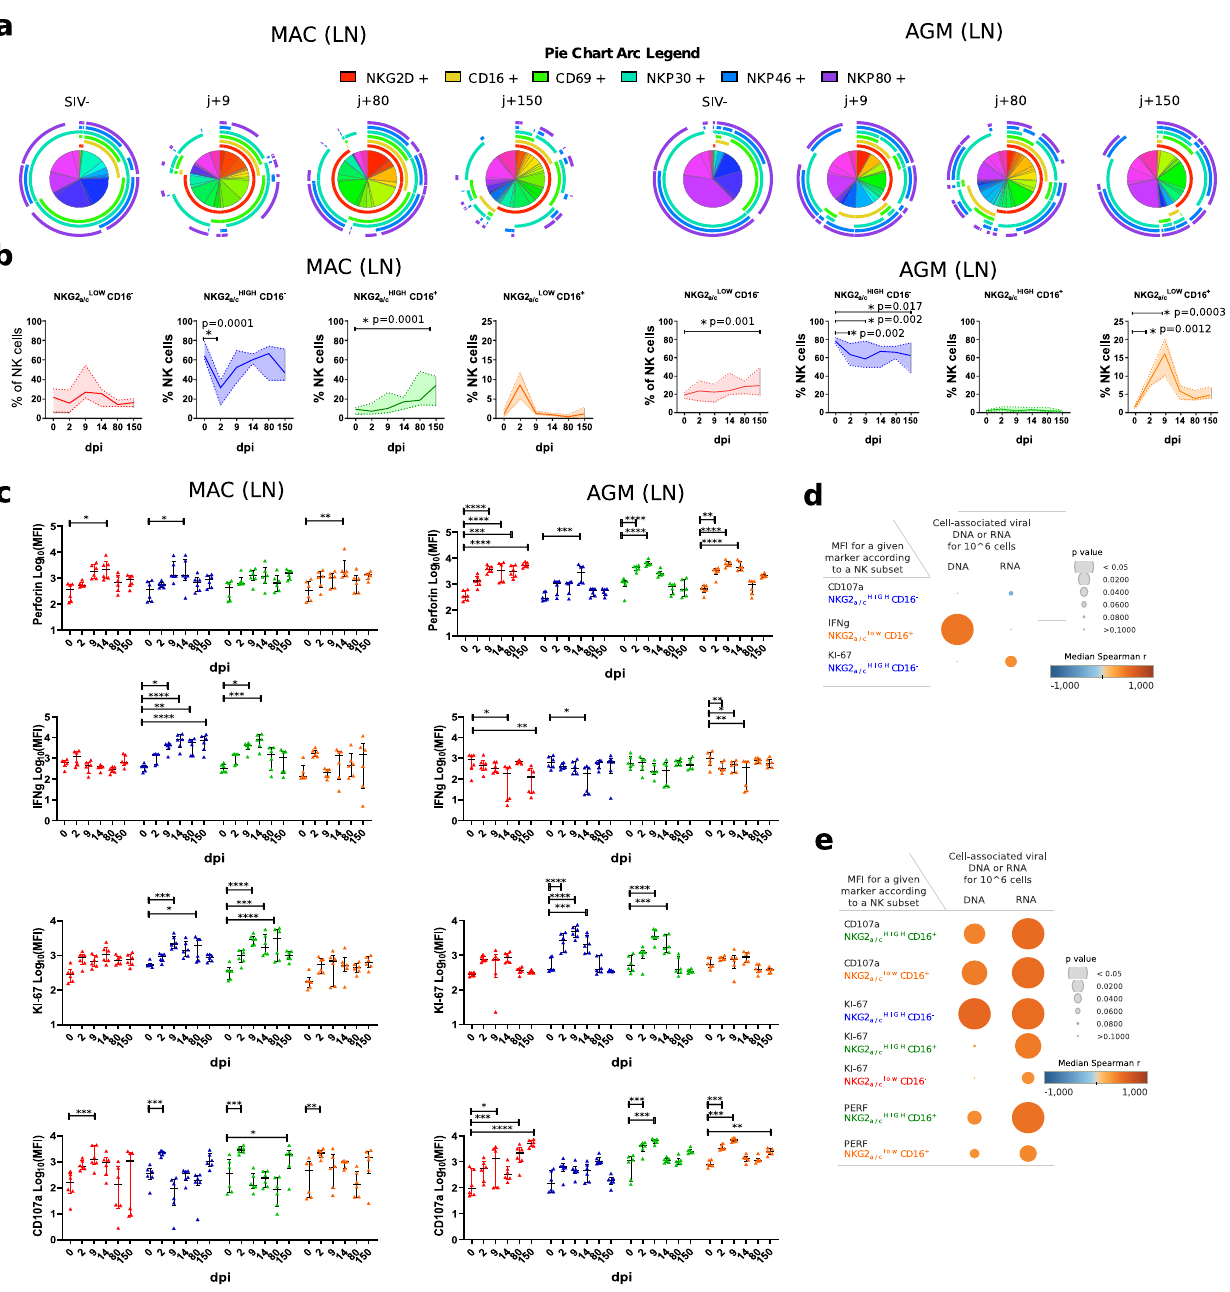
Fig. 3 Dynamics of NK cell repertoire and activity in response to SIV infection in LN. a Pie charts and arcs showing the proportion of different combinations of markers on NKG2a + NK cells isolated from LN during SIVmac (left panel) and SIVagm (right panel) infections, as analyzed using SPICE 5.3. b Frequency of NK cell subpopulations out of total NK cells in LN. Colors are the same as in Fig. 1. Cells were sampled before and during SIVmac and SIVagm infection ( n = 6 animals per species) at the time point indicated by the X axis. The full line indicates the median, and the interquartile range is indicated by the area between the dotted lines. For Groups comparisons two-sided Wilcoxon signed-rank test with Bonferroni correction were used ( n = 6). P values ≤ 0.05 were considered statistically signi fi cant. Asterix indicate signi fi cant change when compared to the base line. Exact P values are provided on the graphs. c Longitudinal pro fi les of intracellular levels of Perforin, interferon gamma, Ki-67, and surface level of CD107a on NK cell subsets ex vivo during SIVmac (left panel) and SIVagm (right panel) infections without any prior stimulation. The colors for each NK cell subpopulation are the same as in Fig. 1. Each symbol represents one monkey, the black line indicates the median and error bars the interquartile range. For group comparisons, two-sided Wilcoxon signed-rank test with Bonferroni correction was used ( n = 6). P values ≤ 0.05 were considered statistically signi fi cant. Asterix indicate signi fi cant change when compared to the base line, graphically annotated as follows: * p < 0.05; ** p < 0.01; *** p < 0.001; **** p < 0.0001. d , e Pearson correlation matrix between viral load in LN (ca-vDNA and ca-vRNA) and expression level of functional markers showed in Fig. 3c for d MAC and e AGM. The orange and blue colors indicate higher and lower r value. The p value is indicated by the size of the circle. All p and r values are given in the Data Source fi le.